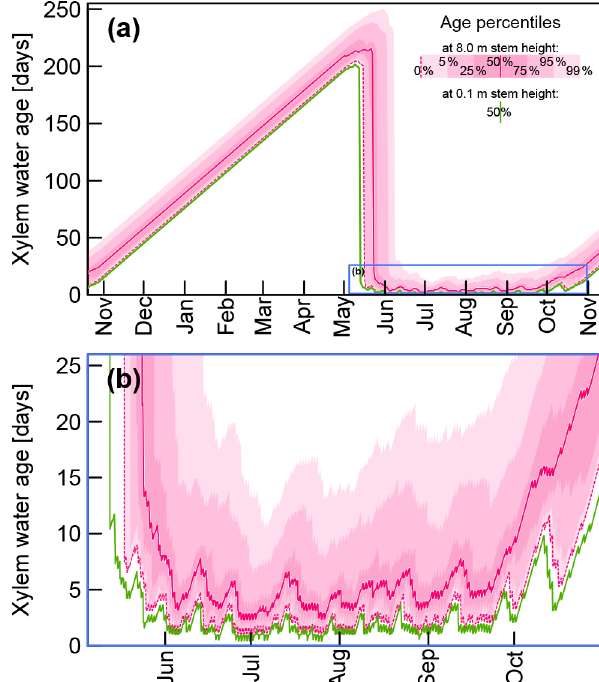
Figure 8. Selected quantiles of modeled xylem water ages at 0.1m stem height (green) and 8m stem height (pink) based on FPLDs h F1 and h F1F2 , respectively, and time-variable sap flow velocities. Panel (b) shows the subset of (a) which is marked by the blue